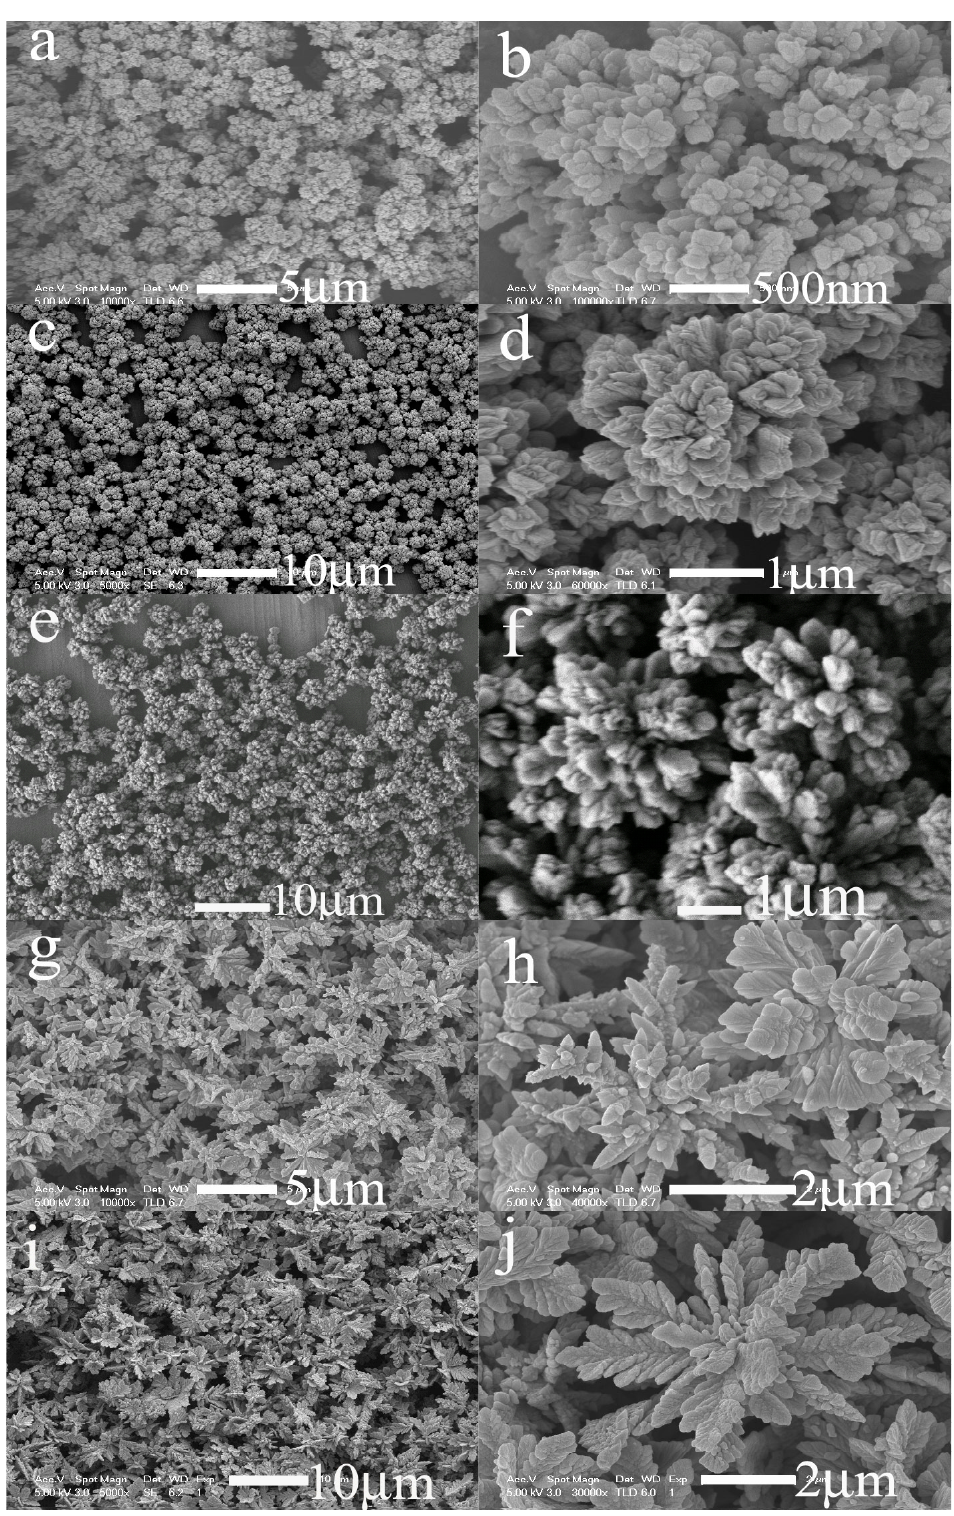
Figure 4. Different magnification FESEM images of the products with the temperatures: (a) and (b) 140 o C; (c) and (d) 160 o C; (e) and (f) 180 o C; (g) and (h) 200 o C, (i) and (j) 220 o C